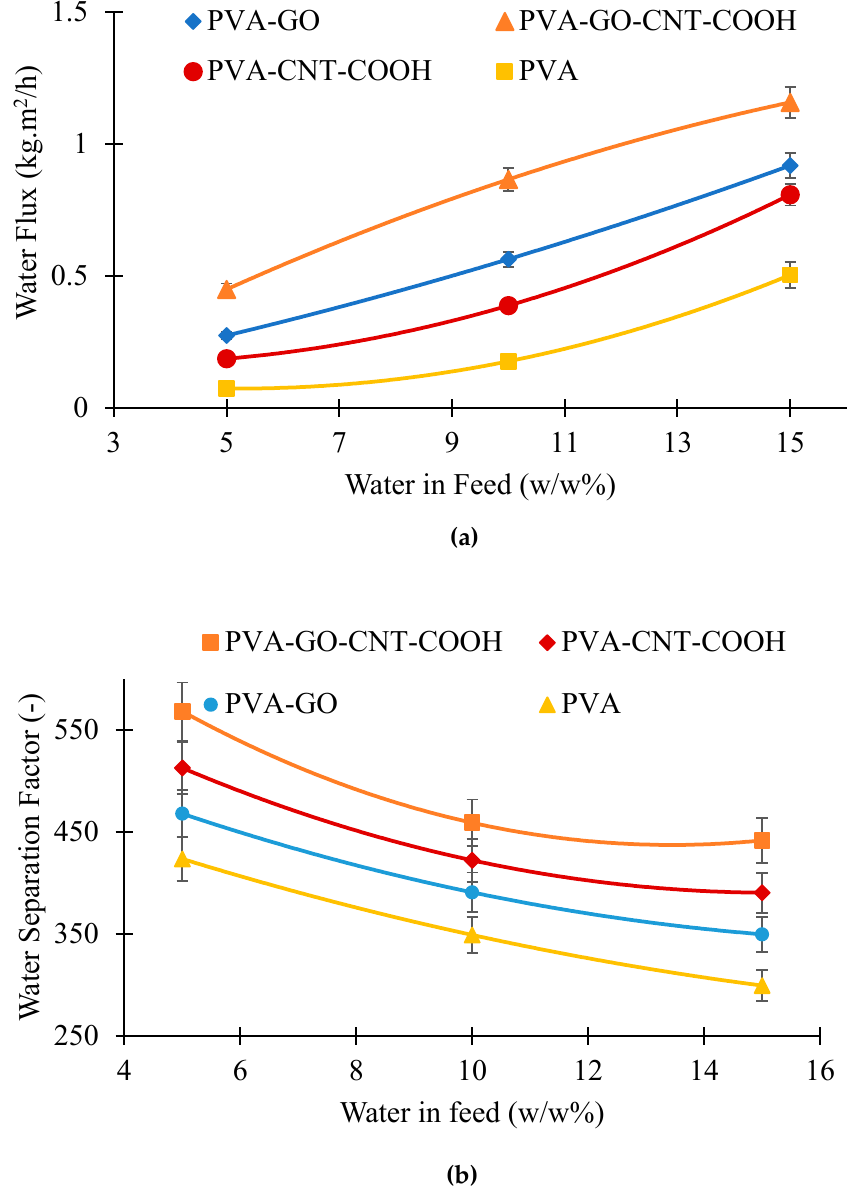
Figure 11. Effect of feed concentration on ( a ) water flux; ( b ) water separation factor at 50 °C.